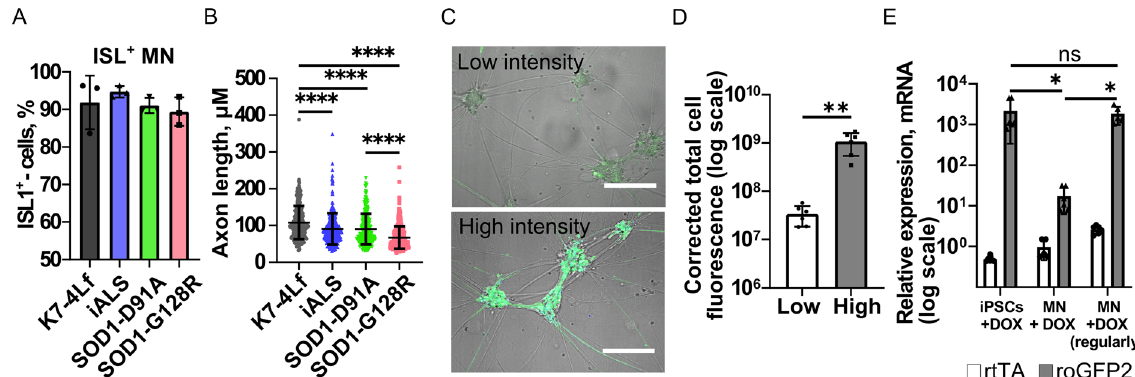
Figure 3. Generation of iPSC-derived motor neurons (MNs) expressing the Cyto-roGFP2-Orp1 and Mito- roGFP2-Orp1 biosensors. ( A ) Quantification of flow cytometry analysis of ISL-positive cells was performed on day 20 of the differentiation protocol: K7-4Lf (isogenic control MNs without mutations), iALS (patient- specific MNs with D91A mutation in SOD1 ), SOD1-D91A (isogenic MNs with D91A mutation in SOD1 ), and SOD1-G128R (isogenic MNs with G128R mutation in SOD1 ). Data (N = 3 independent differentiations) are the mean ± standard deviation (S.D.) ( B ) Axon length quantification (differentiation day 21). Data was collected from three independent differentiations with a total of 257, 270, 409, and 397 cells analyzed for K7-4Lf, iALS, SOD1-D91A, and SOD1-G128R MNs, respectively, and are presented as the mean ± S.D. ( C ) Representative images of the MNs with low (top) and high (bottom) intensity signals form Cyto-roGFP2-Orp1. Scale bar 100 μm. ( D ) Quantification of the Cyto-roGFP2-Orp1 fluorescence intensity in the MNs with low and high Cyto-roGFP2-Orp1 signal intensity. Data (N = 6 independent differentiations) are the mean ± S.D. ( E ) RT-qPCR analysis of the tetracycline-controlled transcriptional activator (rtTA) and biosensors (roGFP2) mRNA expression 48 h after 2 μg/ml doxycycline addition. iPSCs + DOX—iPSCs expressing biosensor; MN + DOX— MNs supplemented with doxycycline after completion of the differentiation protocol; MN + DOX (regularly)— MNs differentiated with regular doxycycline supplementation. Data (N = 6 independent differentiation) are the mean ± S.D. **p < 0.01, ****p < 0.0001, one-way ANOVA with post hoc Tukey’s tests for ( B ) and ( E ), Welch t-test for ( D